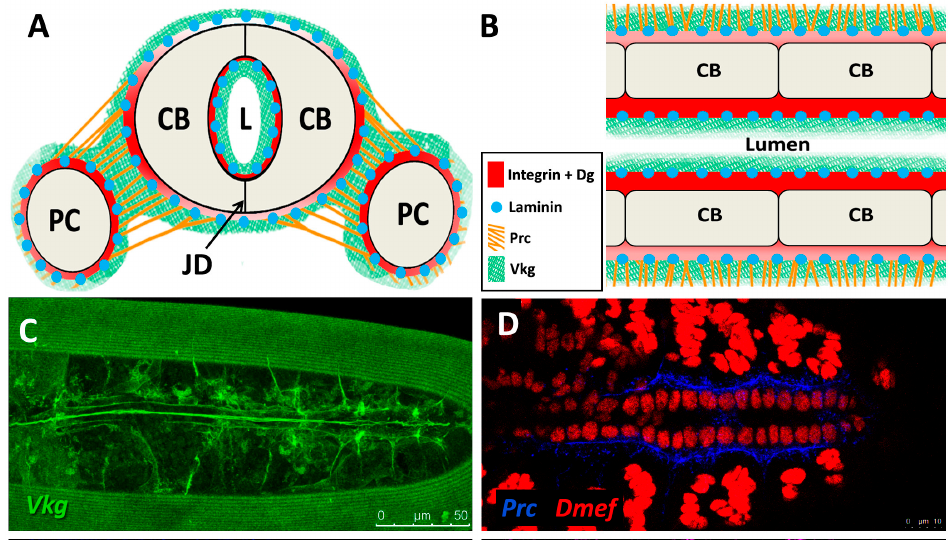
Figure 3. Cont. Figure 3.